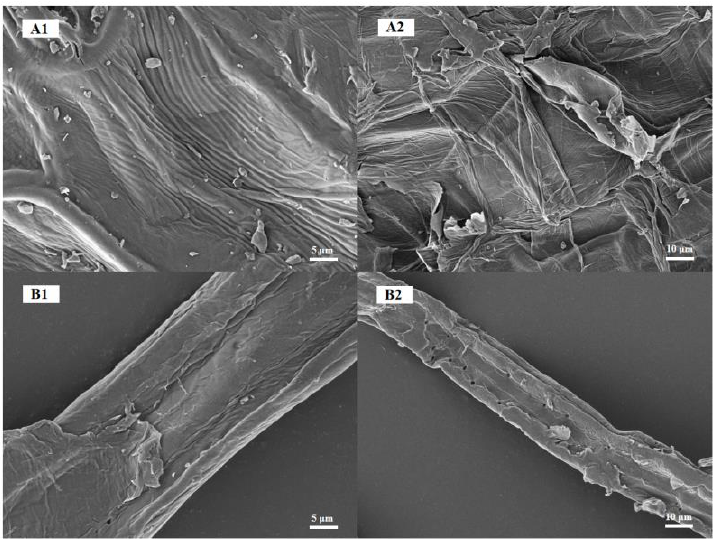
Figure 5. SEM of Corn bract and N-CHB cellulose: ( A1 ) Corn bract powder, 5 μm; ( A2 ) Corn bract powder, 10 μm; ( B1 ) N-CHB cellulose, 5 μm; ( B2 ) N-CHB cellulose, 10 μm.